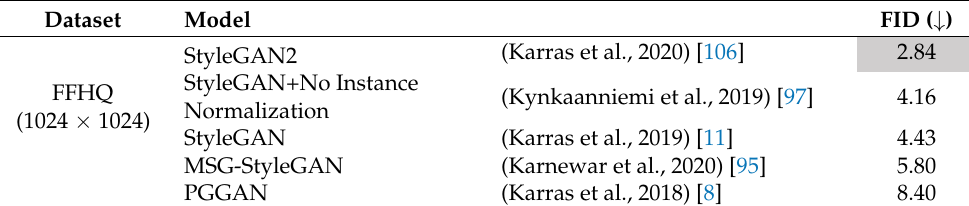
Table 15. The FID of different models trained on FFHQ higher resolution image dataset. The lower the FID value, the better the performance.